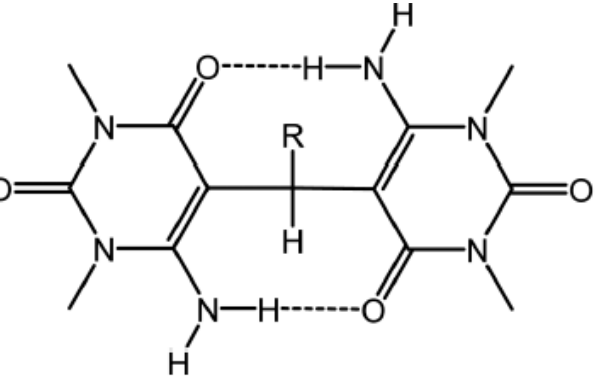
Figure 3. Bis(6 ‐ amino ‐ 1,3 ‐ dimethyluracil ‐ 5 ‐ yl) ‐ methane derivatives. R being ethyl, pyridine or p ‐ dimethylaminopyridine. Taken from [11].